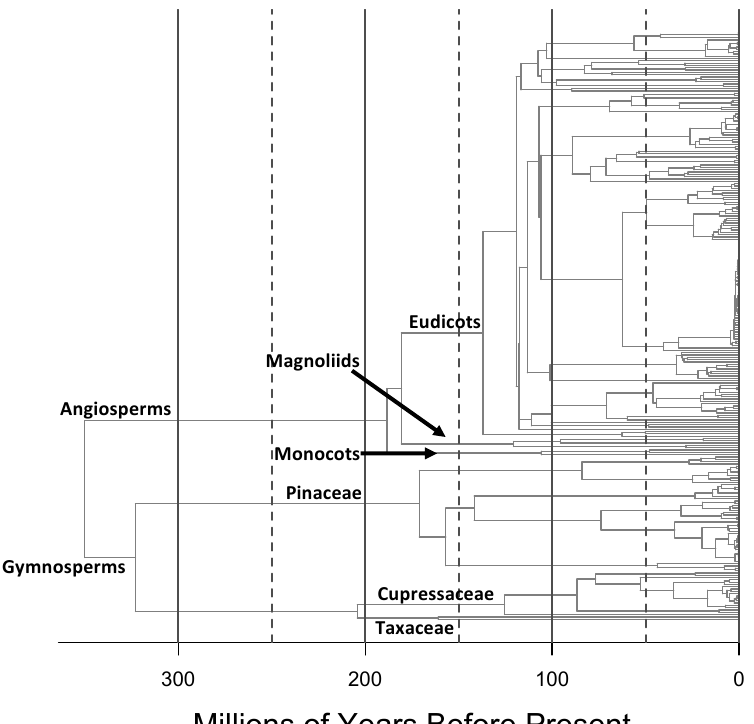
Figure 2. Phylogeny of all tree species present in the contiguous United States in the US Forest Inventory and Analysis (FIA) dataset, based on the phylogenies for gymnosperms and angiosperms in Ma et al.